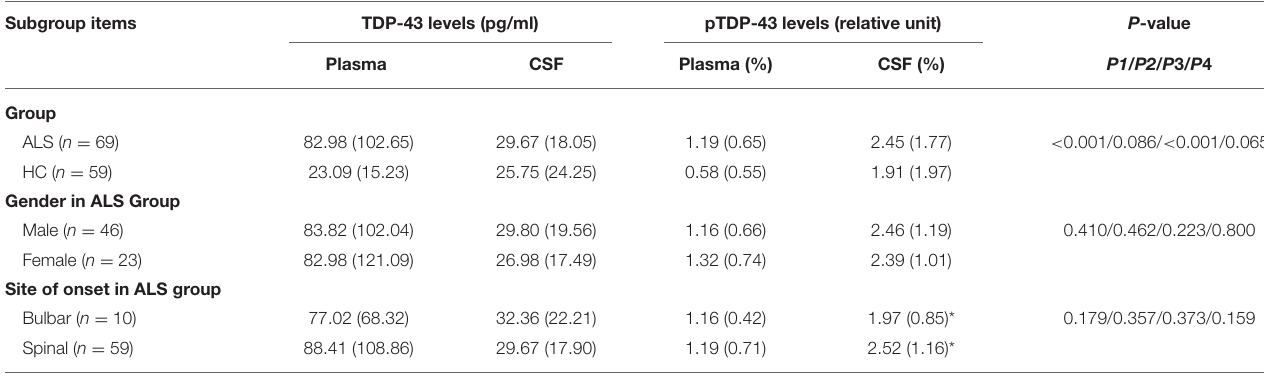
TABLE 2 | Plasma and CSF TDP-43/pTDP-43 concentrations in different groups. Subgroup